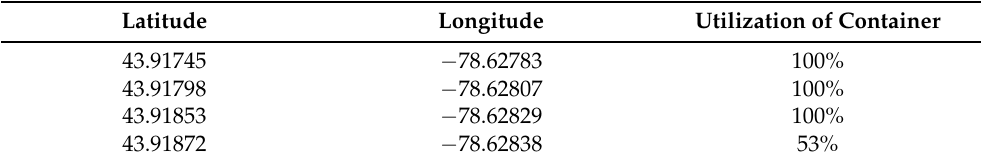
Table 10. The containers are fully utilized, however the last container is only half full and is placed too close to the 3rd container, and the other three containers have high spacing between them. This is a less favorable option for the farmer as it adds extra time and effort for the harvesters.